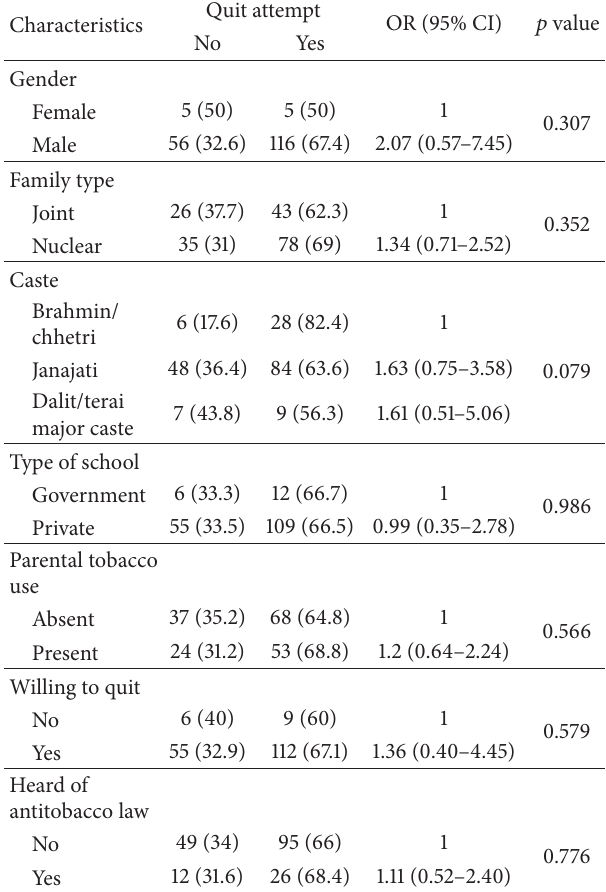
Table 3: Factors associated with quitting attempts ( 𝑛 = 182